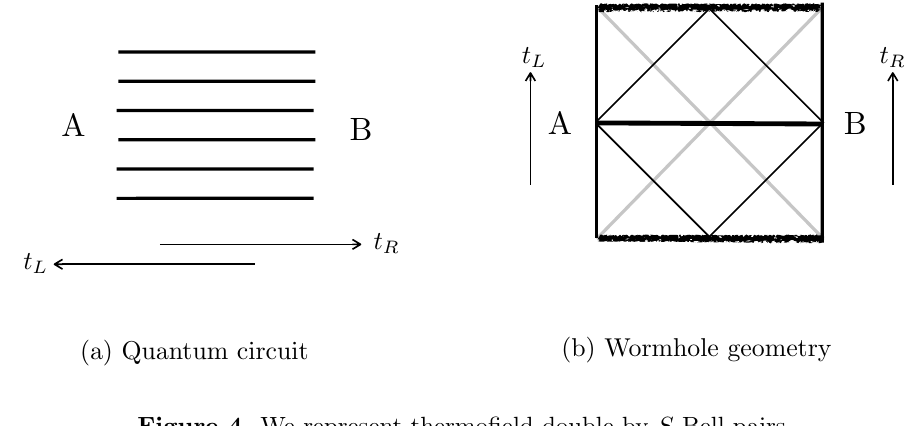
Figure 4 . We represent thermo(cid:12)eld double by S Bell pairs.